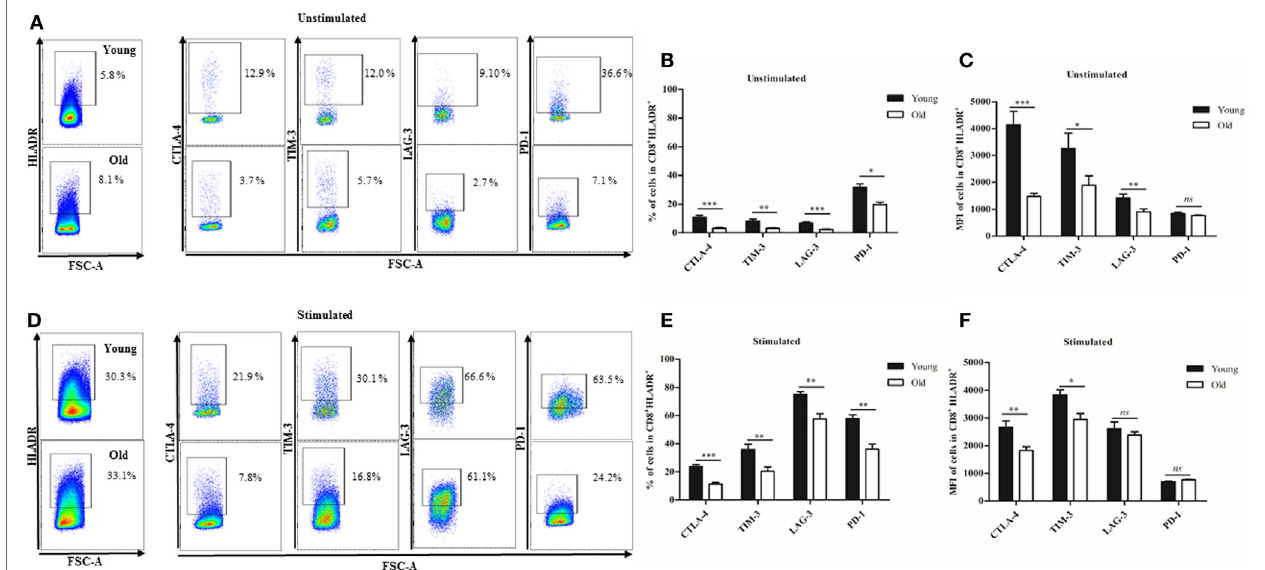
FigUre 7 | Expression of checkpoint inhibitory molecules on CD8 + human leukocyte antigen–antigen D related (HLADR) + T cells in young and old persons. (a) Representative FACS plots of inhibitory molecules in the CD8 + HLADR + population from one young (upper panel) and one old (lower panel) donor before stimulation. (b) Expression of checkpoint inhibitory molecules (percentages) in CD8 + HLADR + cells from young and old donors before stimulation; young donors n = 22 ( < 30 years) and old donors n = 20 ( > 70 years), mean ± SEM, *** p < 0.0001, ** p < 0.001, * p < 0.05. (c) Expression of checkpoint inhibitory molecules (MFI) in CD8 + HLADR + cells from young and old donors before stimulation; young donors n = 20 ( < 30 years) and old donors n = 18 ( > 70 years), mean ± SEM, *** p < 0.0001, ** p < 0.001, * p < 0.05. (D) Representative FACS plots of inhibitory molecules in the CD8 + HLADR + population from one young (upper panel) and one old (lower panel) donor following stimulation with anti-CD3 (1 µg/ml) and anti-CD28 (0.5 µg/ml) for 24 h. (e) Expression of checkpoint inhibitory molecules